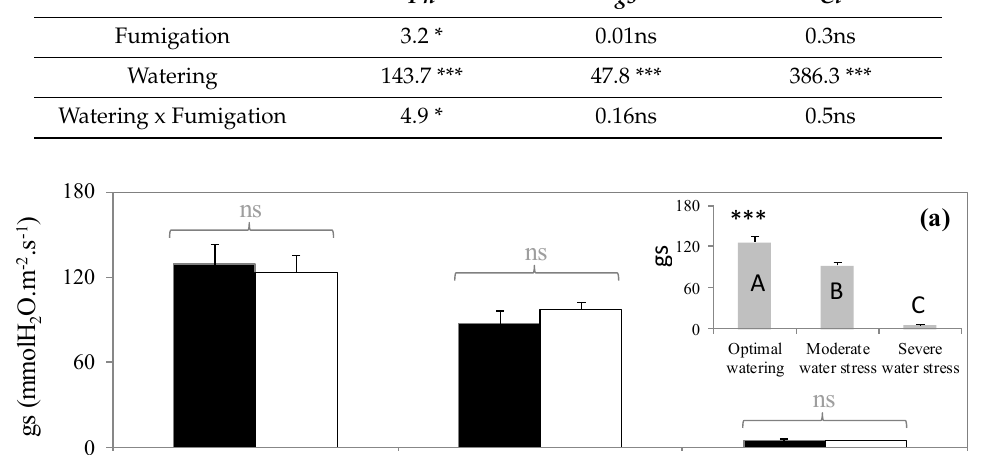
Table 2. Effect of watering and fumigation on net photosynthesis ( Pn ), stomatal conductance to water (gs ) and intercellular CO 2 concentration (Ci) . Values shown correspond to the ANOVA value. *: 0.01 < p < 0.05, ***: p < 0.001. ns: not significant. n = 5.